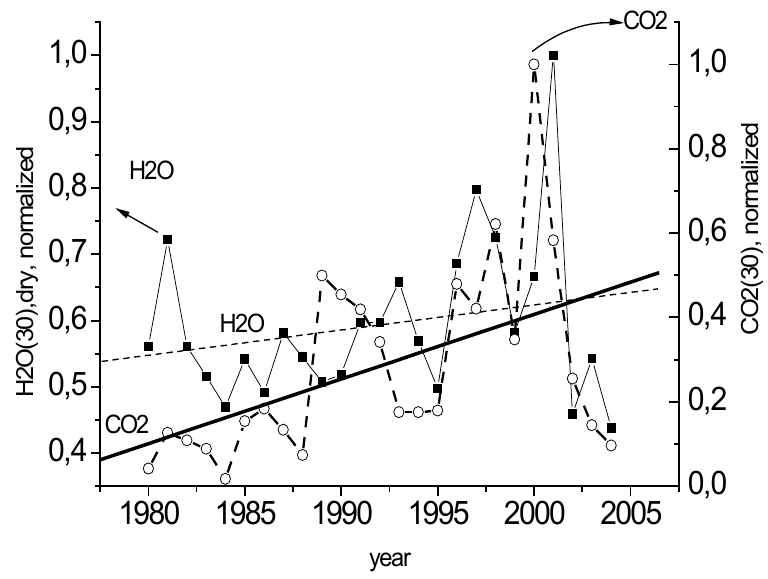
Figure 4. The tree-ring CO (No. 30) obtained by two